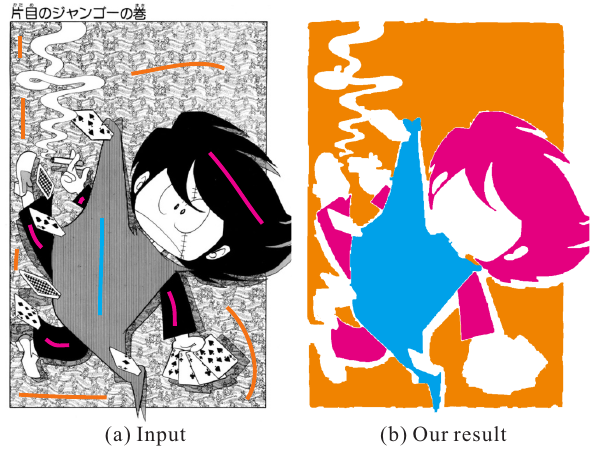
Fig. 12 ‘Poker’ (838 × 1210, loading time: 7.05s, processing time: 4.72s).